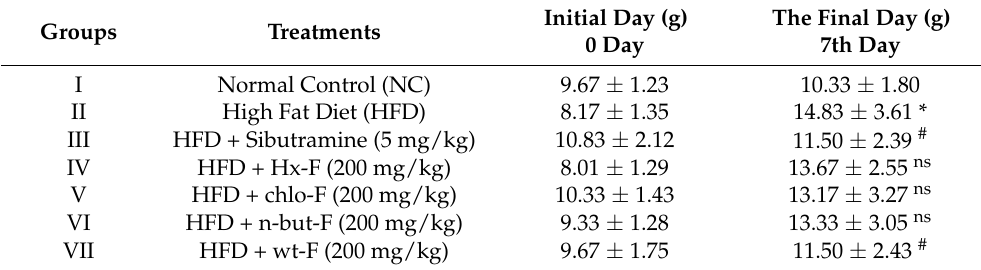
Table 7. Effects of Boerhavia diffusa root fractions (WT-F) on food intake in SD rats after seven days of